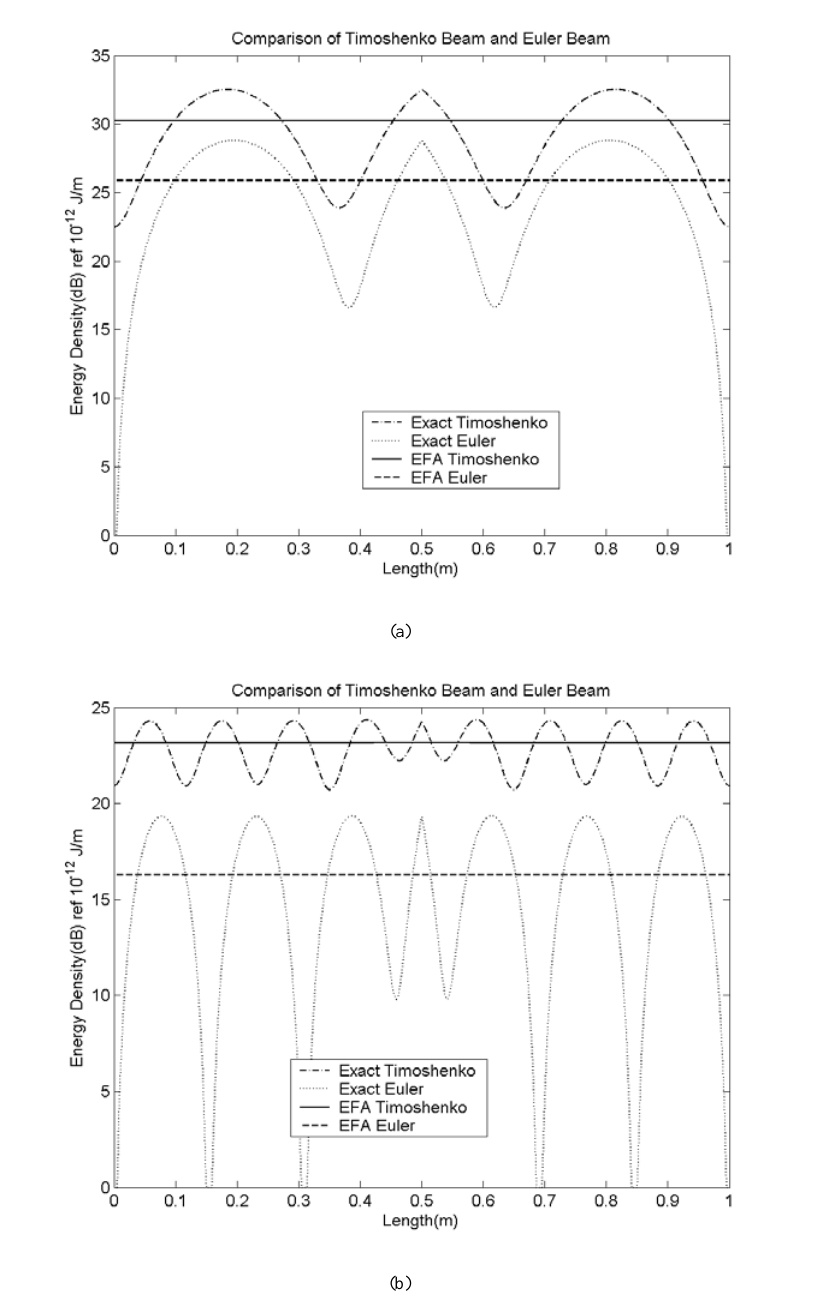
Fig. 9. The energy density level distributions of the Timoshenko beam ( L / H = 10, f c = 15.9 kHz) when η = 0.01. The reference energy density is 10 − 12 J/m: (a) f = 1.5 kHz, (b) f = 10 kHz, (c) f = 30 kHz, (d) f = 60 kHz: - · - · -, classical solution of the Timoshenko beam; ····· , classical solution of the Euler-Bernoulli beam, —, EFA solution of the Timoshenko beam; ---, EFA solution of the Euler-Bernoulli